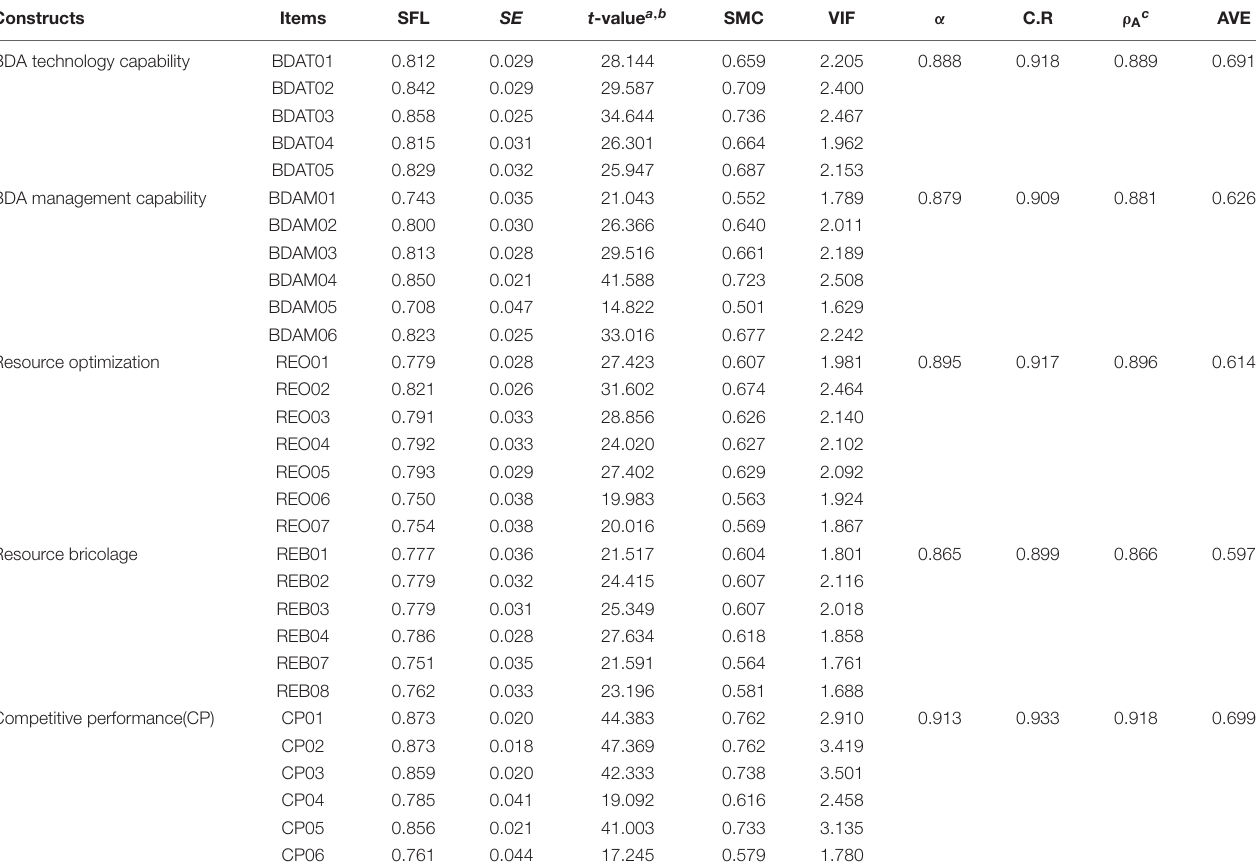
TABLE 2 | The results of reliability of measurement model ( N =